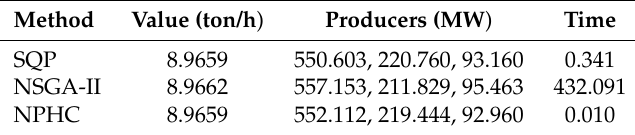
Table 5. Minimization of SO 2